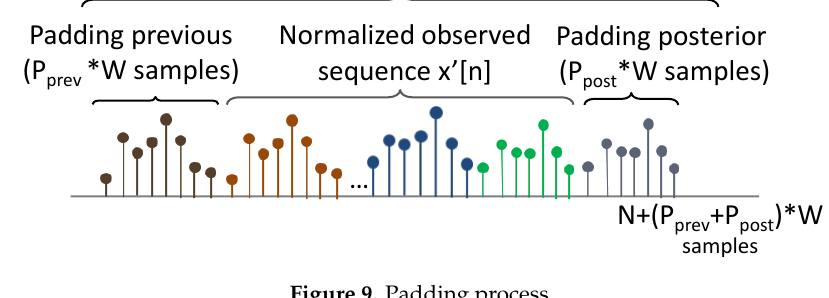
Figure 9. Padding